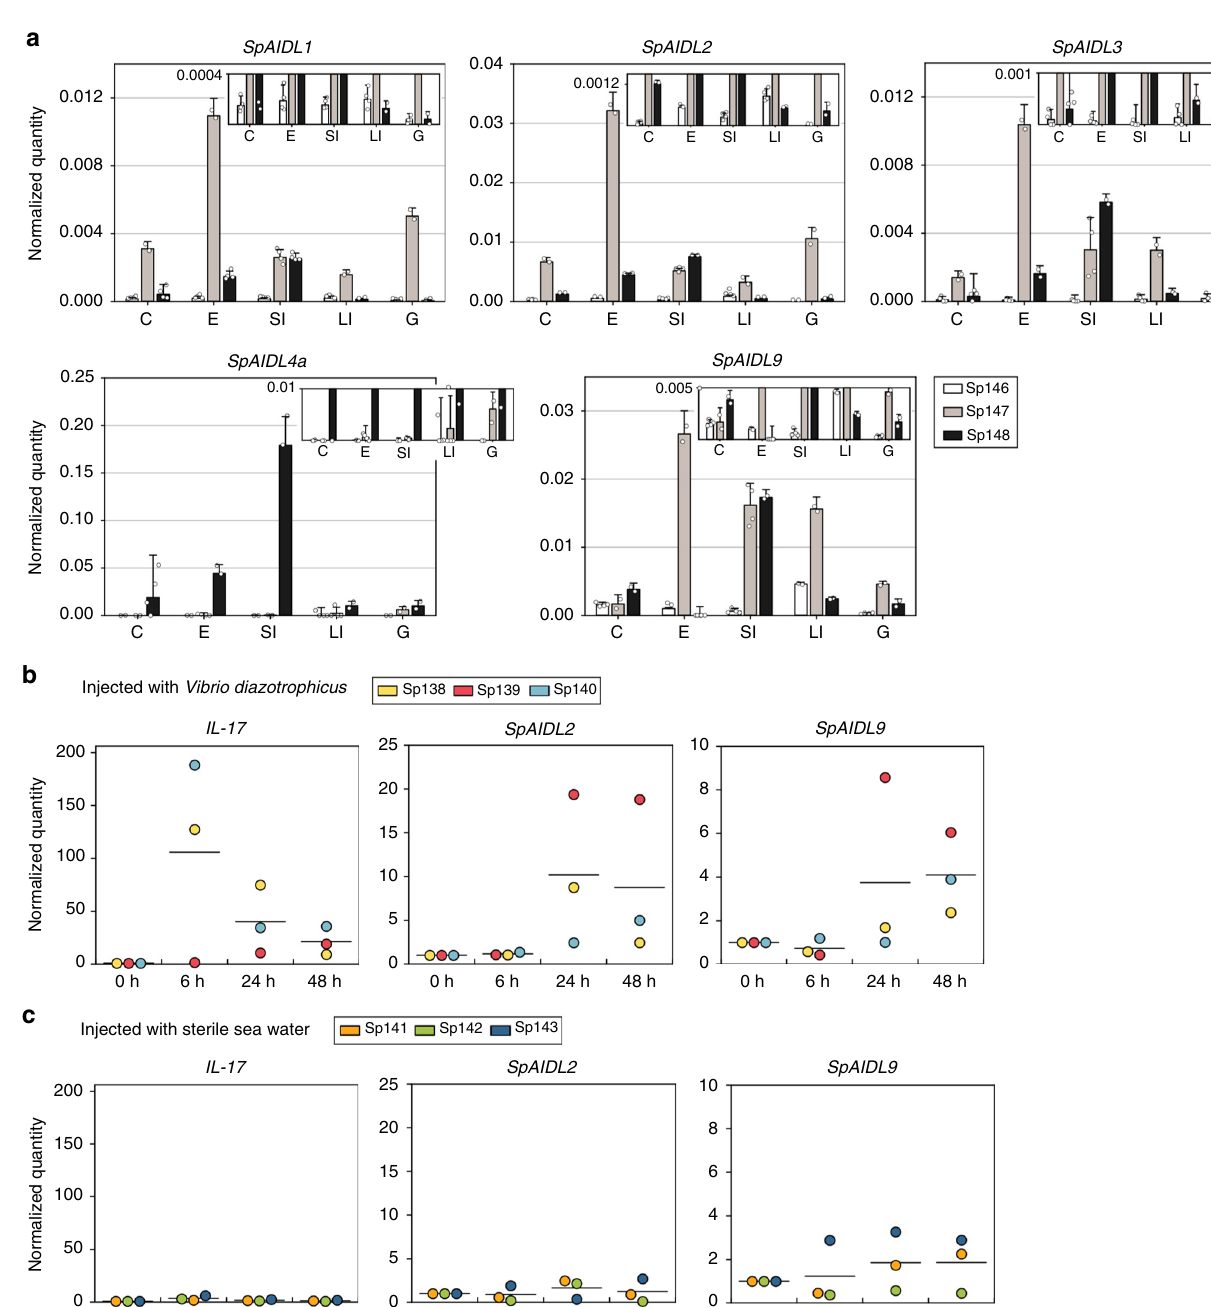
Fig. 2 Expression of SpAIDLs in S. purpuratus . a The expression levels of SpAIDL1, 2, 3, 4a, 9 , and 18S RNAs in coelomocytes (C), the esophagus (E), the small intestine (SI), the large intestine (LI), and the gonad (G) obtained from three individual S. purpuratus (Sp146 ♀ , Sp147 ♂ , and Sp148 ♀ ) were measured by RT- qPCR with two technical replicates per sample. The expression levels are normalized to the amounts of 18S , and the error bars indicate the standard deviation. The insets are a magni fi ed view. b , c Six animals were injected with either live V. diazotrophicus (Sp138, 139, and 140) or sterile sea water (Sp141, 142, and 143). The time course of SpAIDL2 , SpAIDL9 , and SpIL17-9 expression levels were measured by RT-qPCR with each data point being the mean of two technical replicates. The expression levels were fi rst normalized to 18S and then to the expression at t = 0 for each transcript for each sea urchin. The horizontal bars indicate the